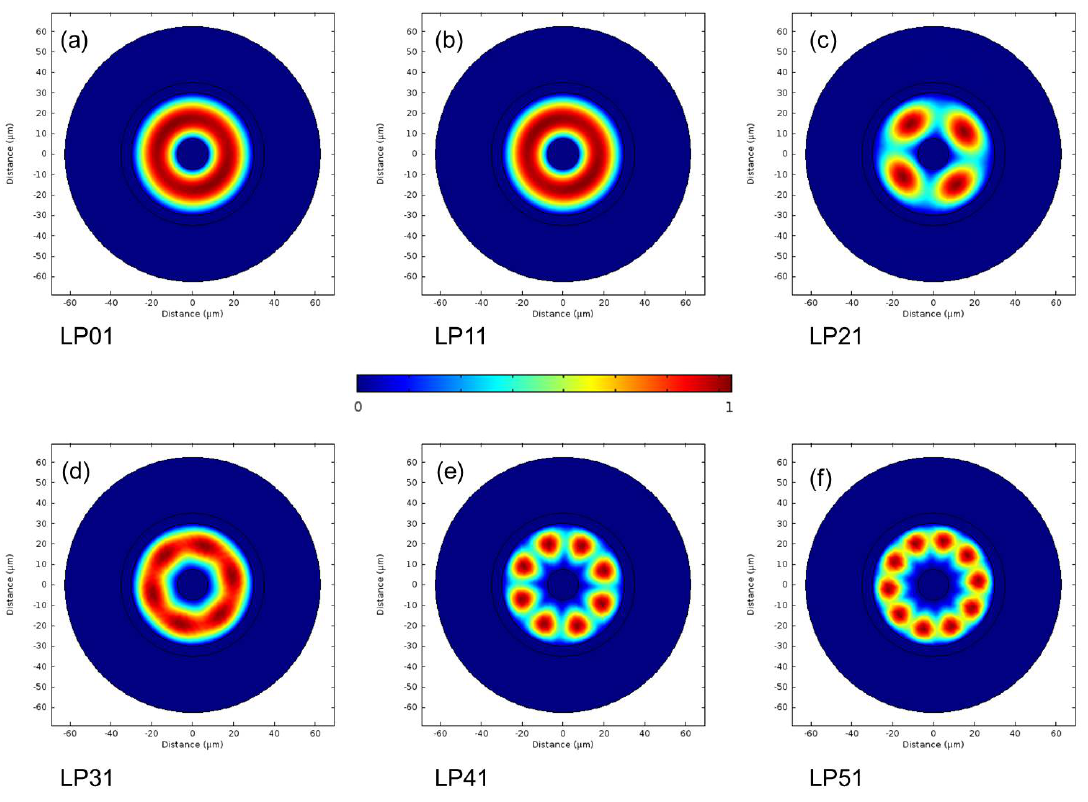
Figure 11. The normalized x - y plane electric field distribution for the first six calculated modes for the inner glass ring. Note: though LP01 and LP11 look similar, they are, in fact, different